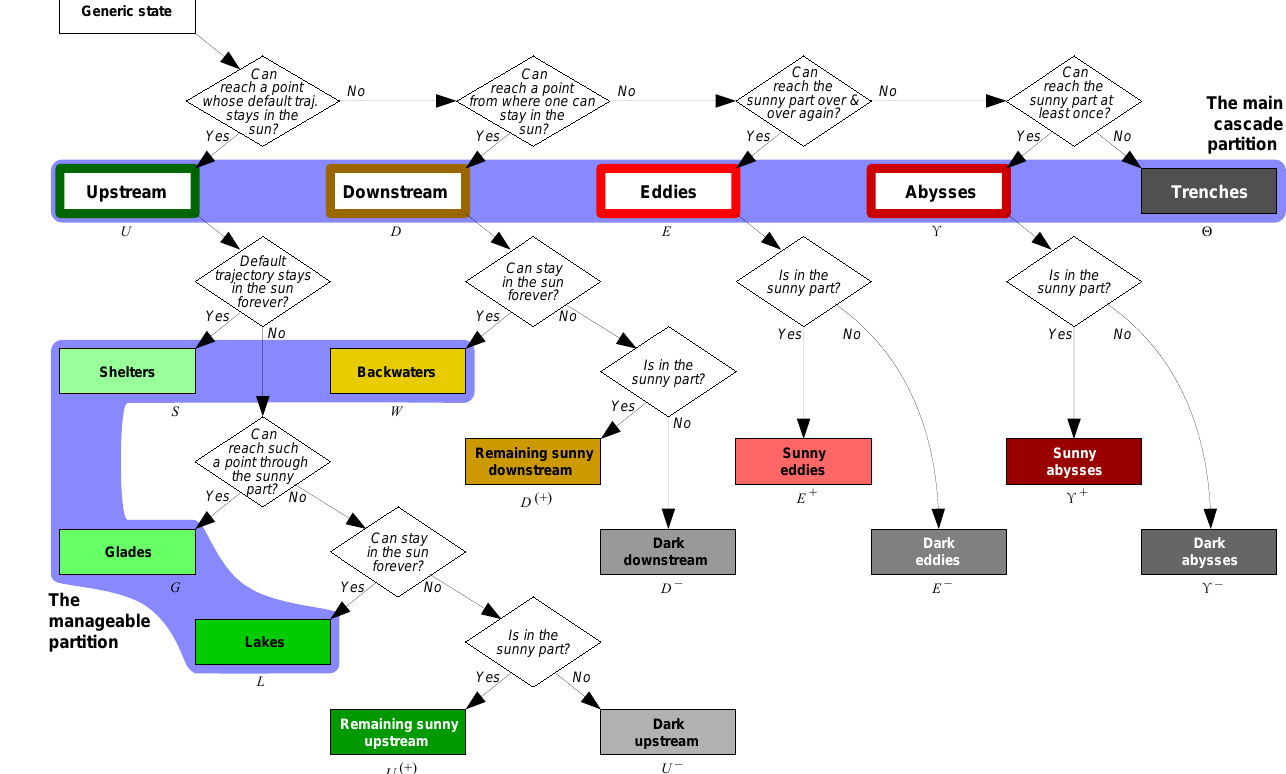
Figure 2. Decision tree summarizing the partition of a manageable dynamical system’s state space with regard to stable reachability of the desired region or the shelters (main cascade), and the finer partition of the manageable region. The colour scheme (grey undesired regions, green upstream regions, yellow downstream regions, red eddies, and abysses, with lighter meaning better) is also used in the remaining